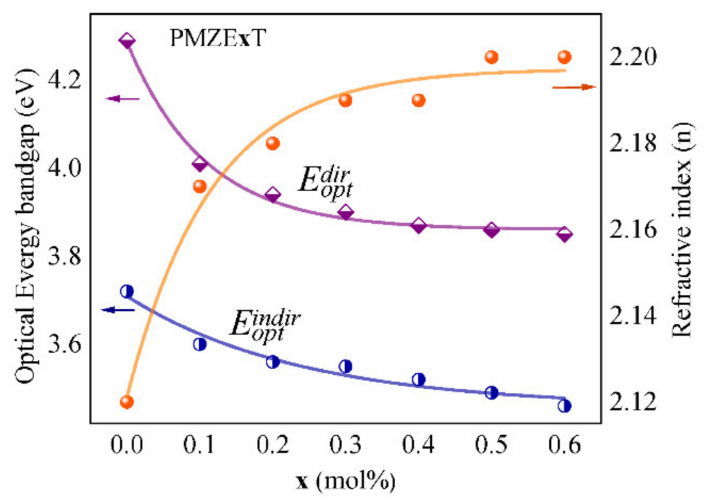
Figure 7. Optical energy bandgap for direct and indirect transitions and refractive index (n) as a function of TiO 2 NPs